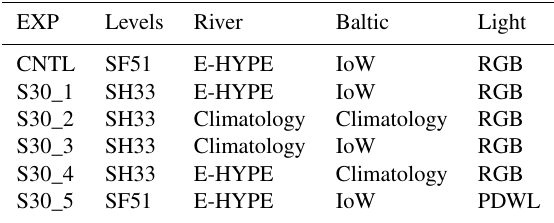
Table 2. The 30-year sensitivity experiments.